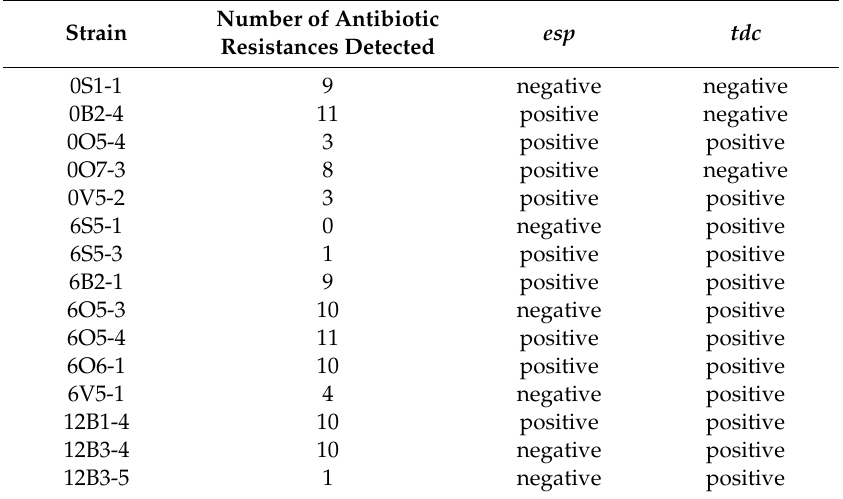
Table 4. Antibiotic resistance, virulence factors (enterococcal surface protein) and biogenic